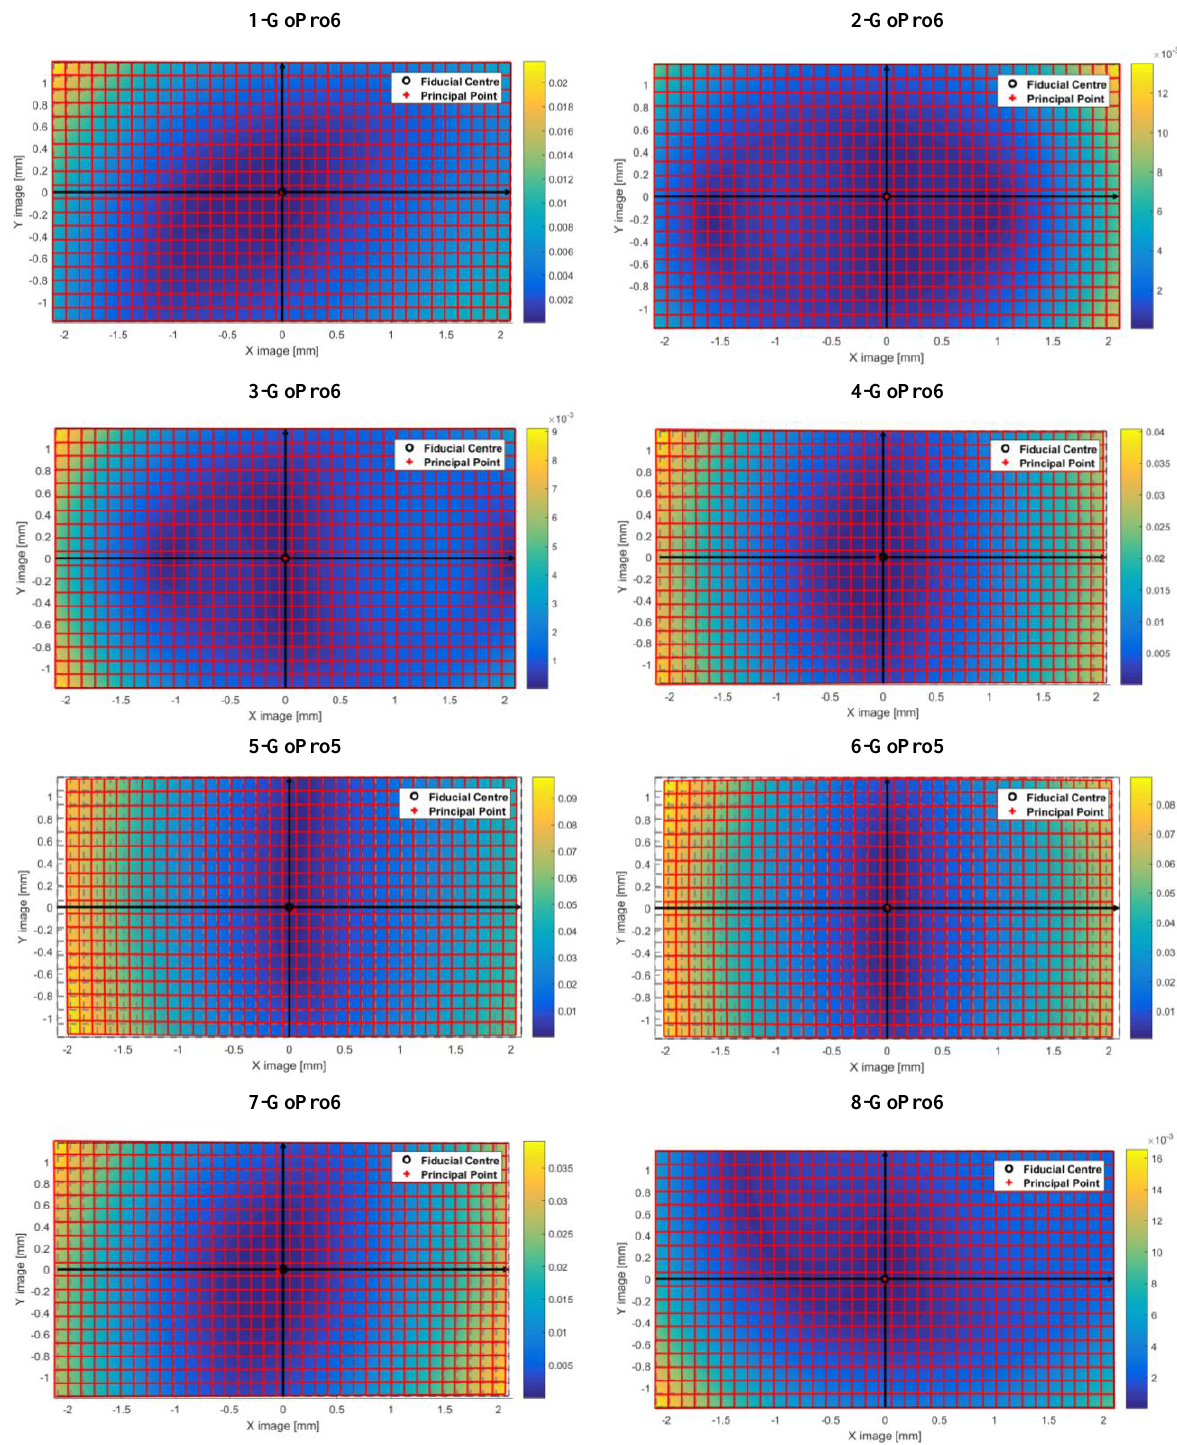
Figure 5. Distortion maps (difference in mm between ideal and actual distorted pixel position) for the eight GoPro